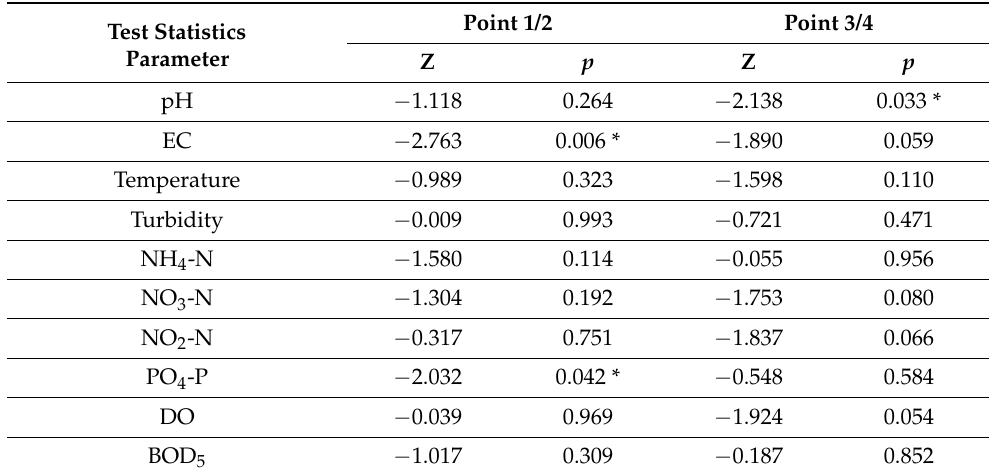
Table 8. Wilcoxon rank test results for research